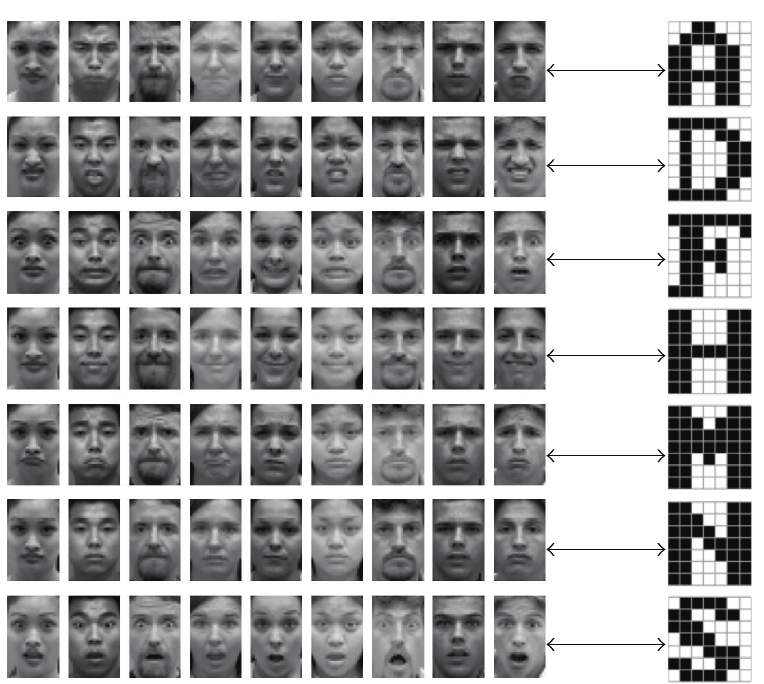
Figure 15: Patterns pairs used to trained the